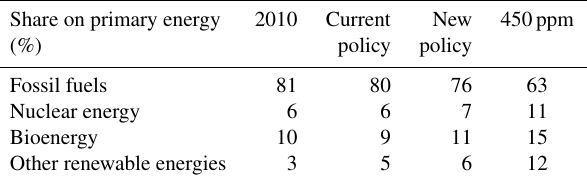
Table A2. Shares of energy sources on total primary energy demand in 2010 and in 2035 for the WEO scenarios (OECD/IEA,